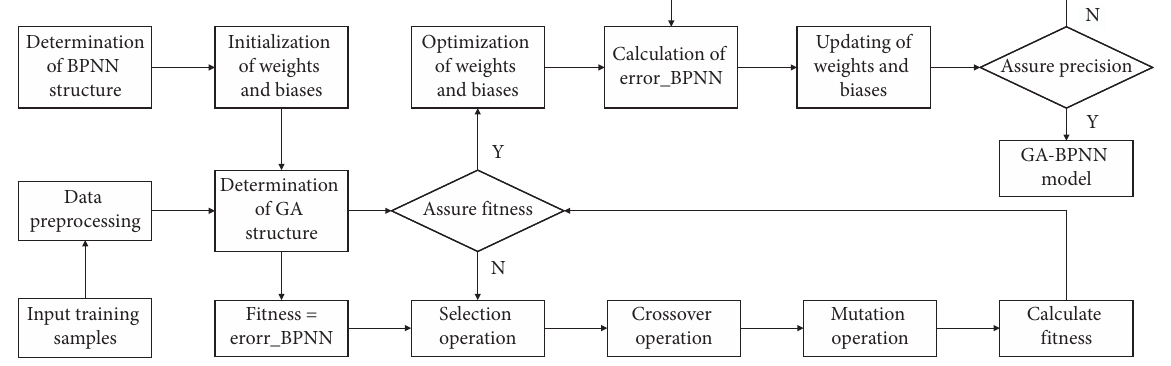
Figure 2: Flowchart of the GA-BP neural